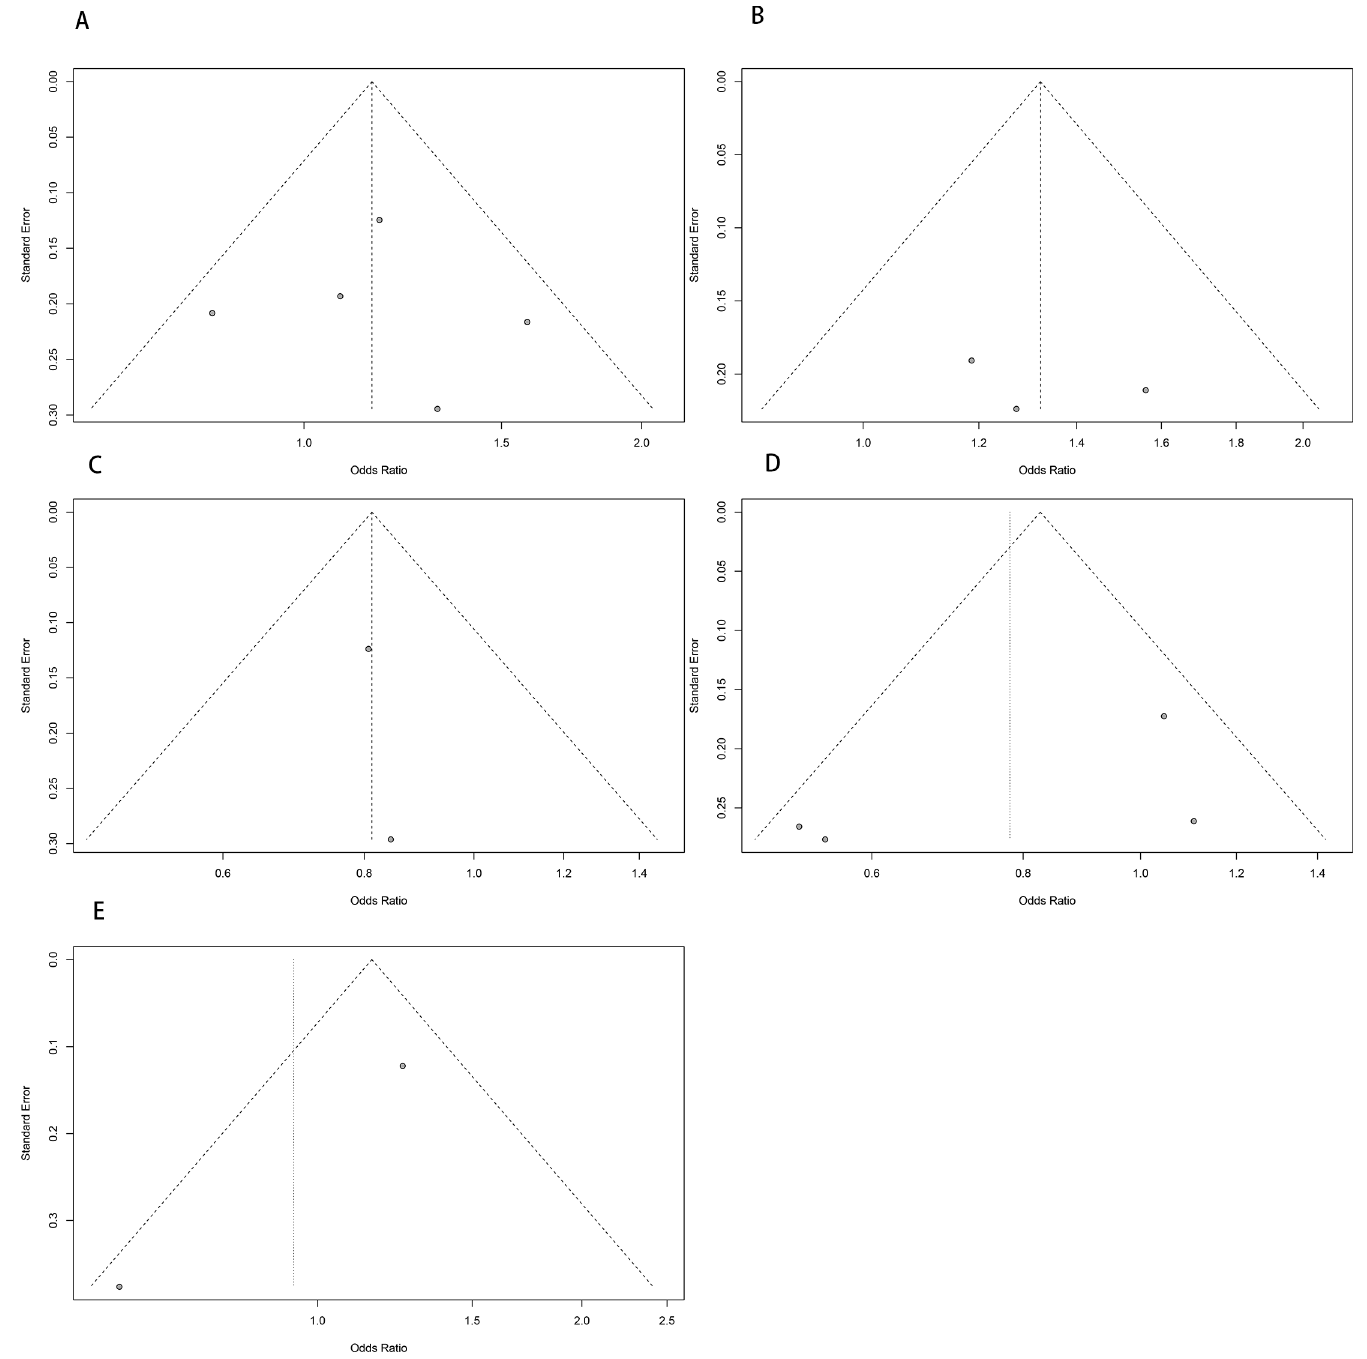
Fig 7. Begg’s funnel plot of the association between five single nucleotide polymorphisms (SNPs) and noise-induced hearing loss (NIHL) in the allele model. A: for rs1043618; B: for rs1061581; C: for rs2075800; D: for rs2227956;E: for rs2763979.